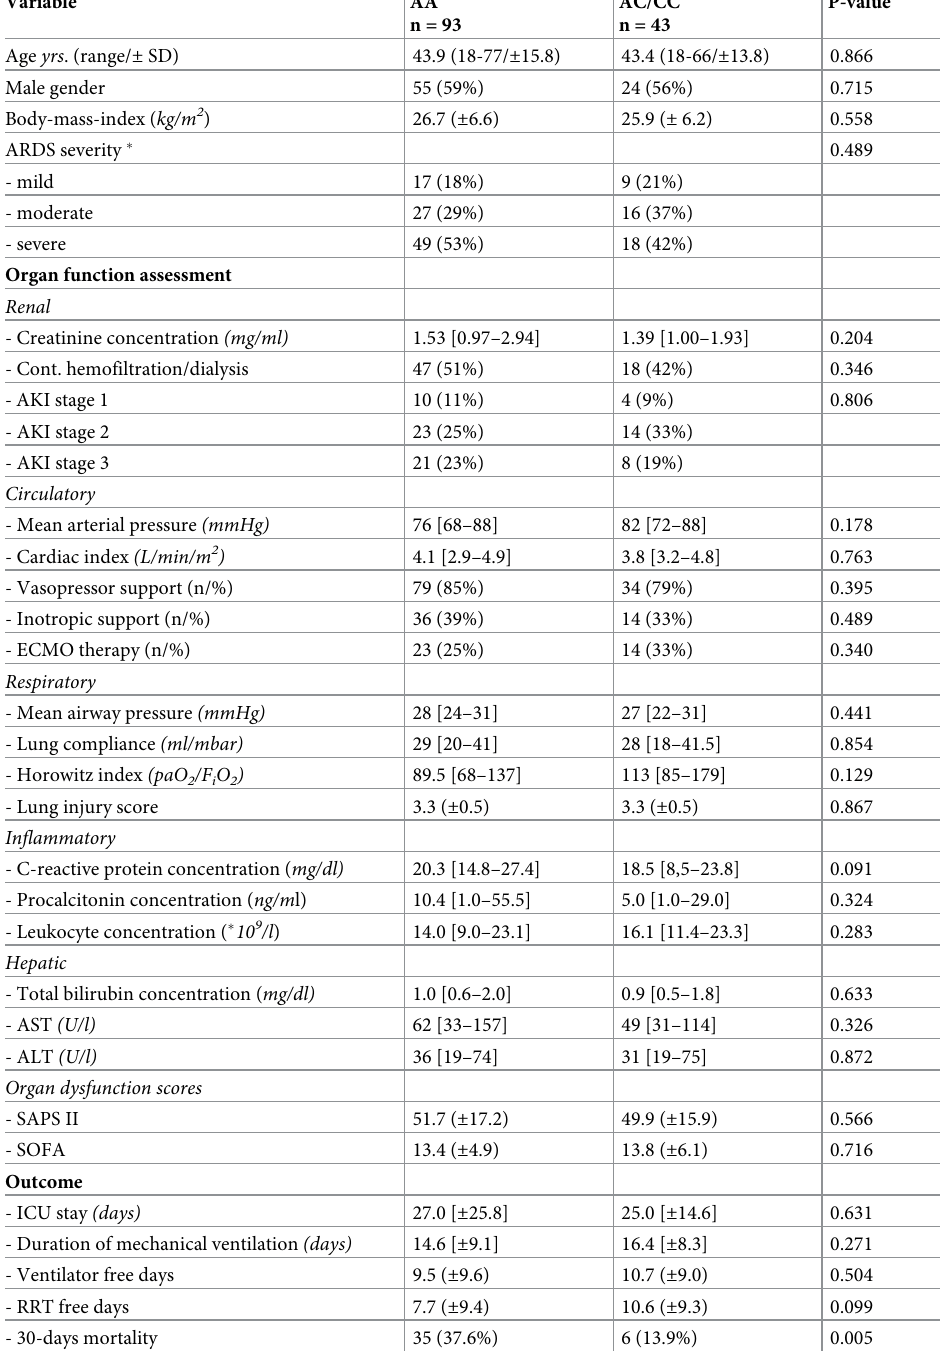
Table 1. Baseline characteristics upon ICU admission of patients with pneumonia evoked ARDS stratified